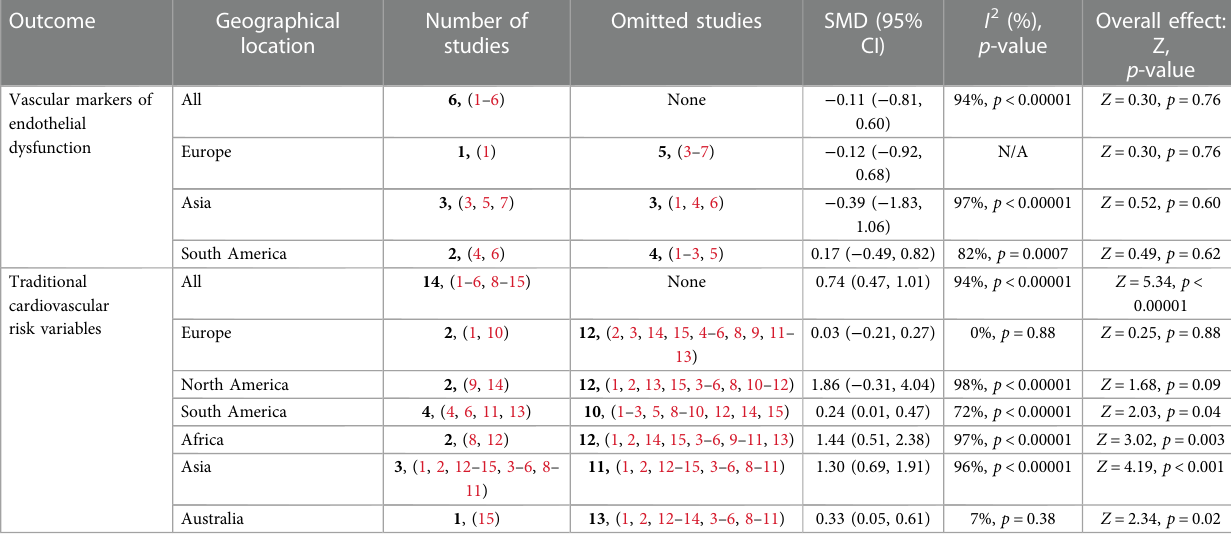
TABLE 3 Sensitivity analysis of outcomes based on geographical location.